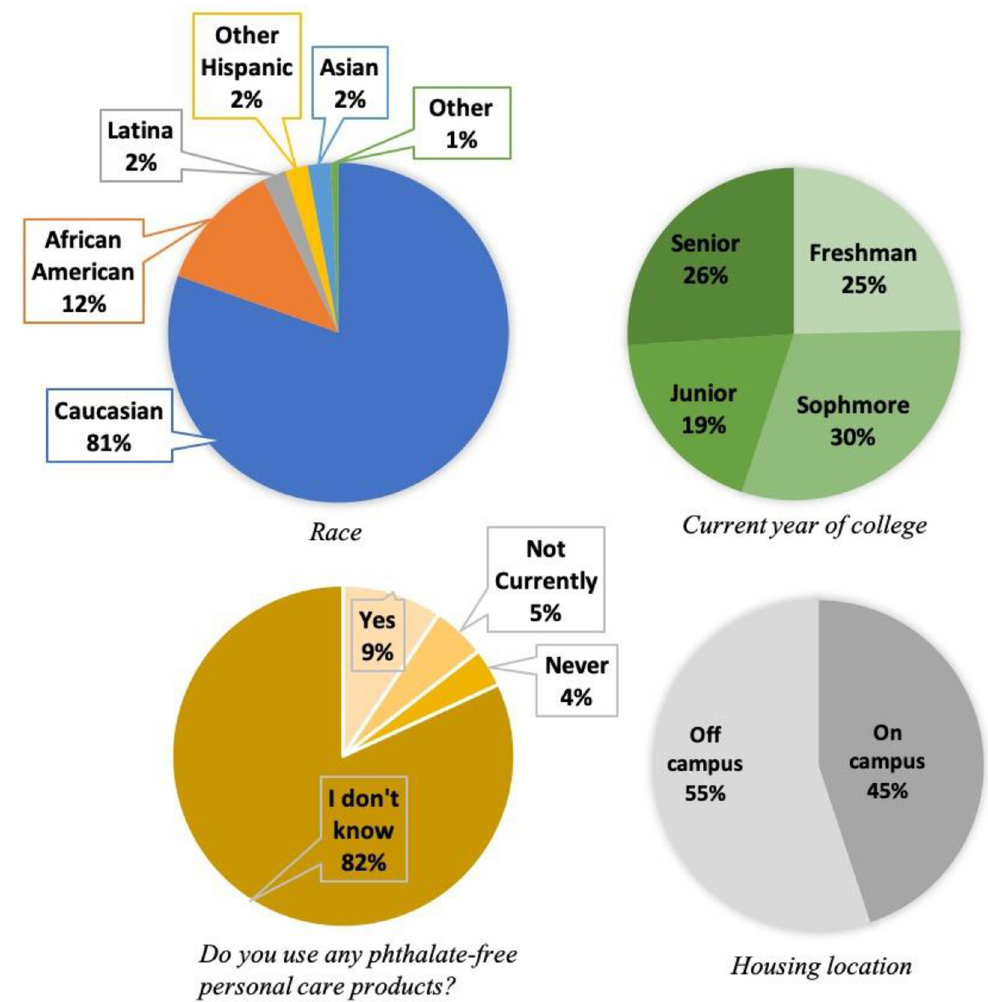
Fig 1. Reported personal information from surveyed undergraduate students. Additional characteristics (parental education, alcohol and tobacco use and personal care and cosmetic use) are tabulated in Hart et al.